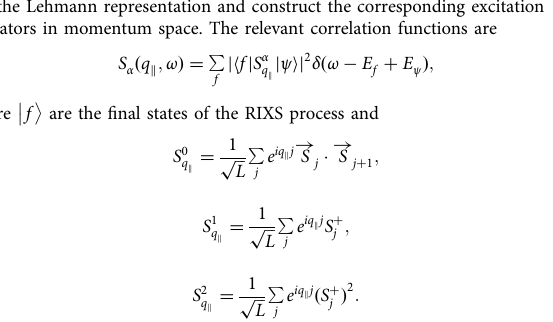
Correlation lengths . Figure 4e of the main text shows dipolar and quadrupolar correlation lengths as a function of temperature. These have been obtained by computing ψ ð β Þ